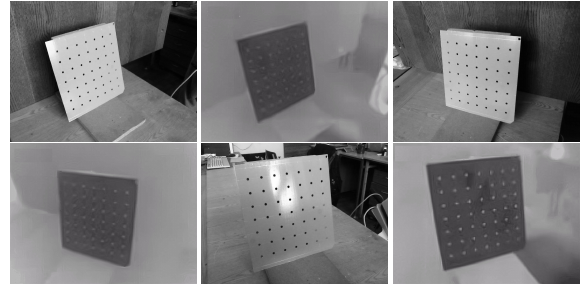
Figure 5. Samples of test field images in visible and thermal range used for calibration Series of 15 images of the test field in different positions and ble and thermal range cameras. Automatically detected reference